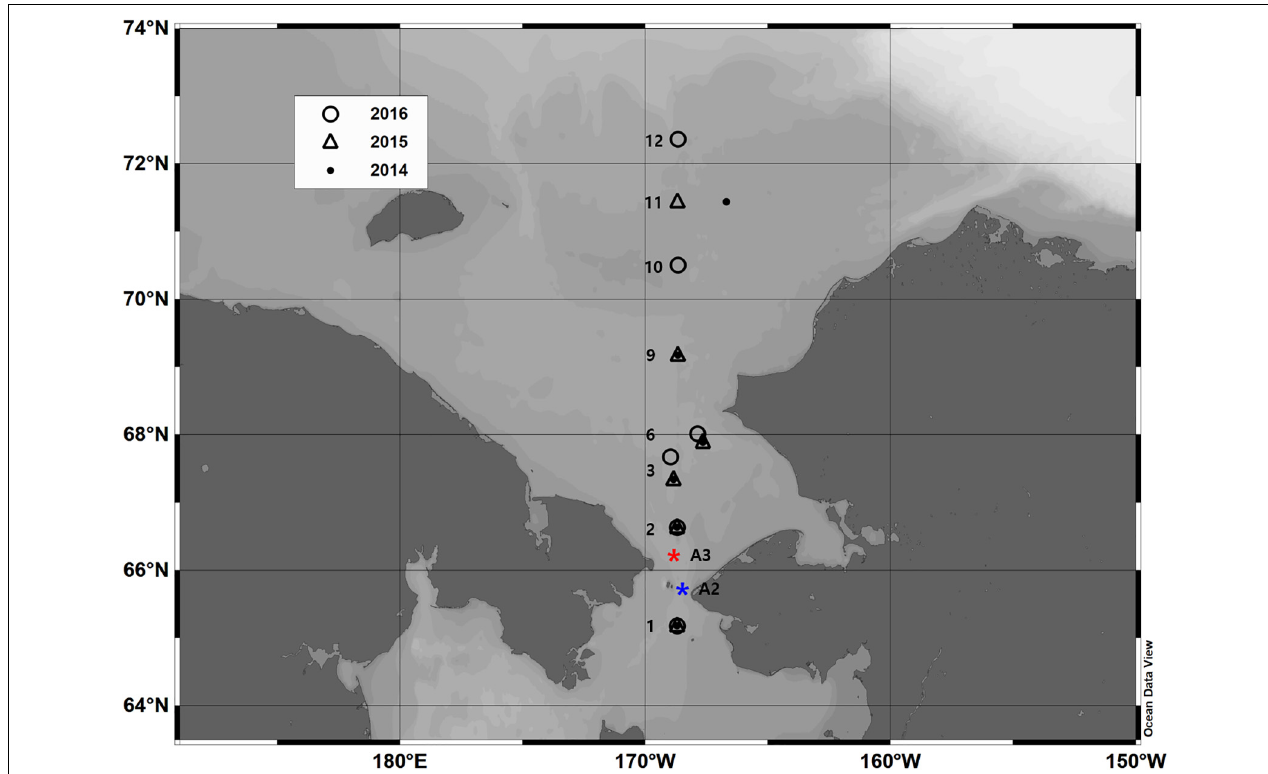
FIGURE 1 | Map of the study area with zooplankton collecting locations represented by circles (2016), squares (2015), and dots (2014). The blue asterisk is the A2 mooring location, and the red asterisk is the A3 mooring